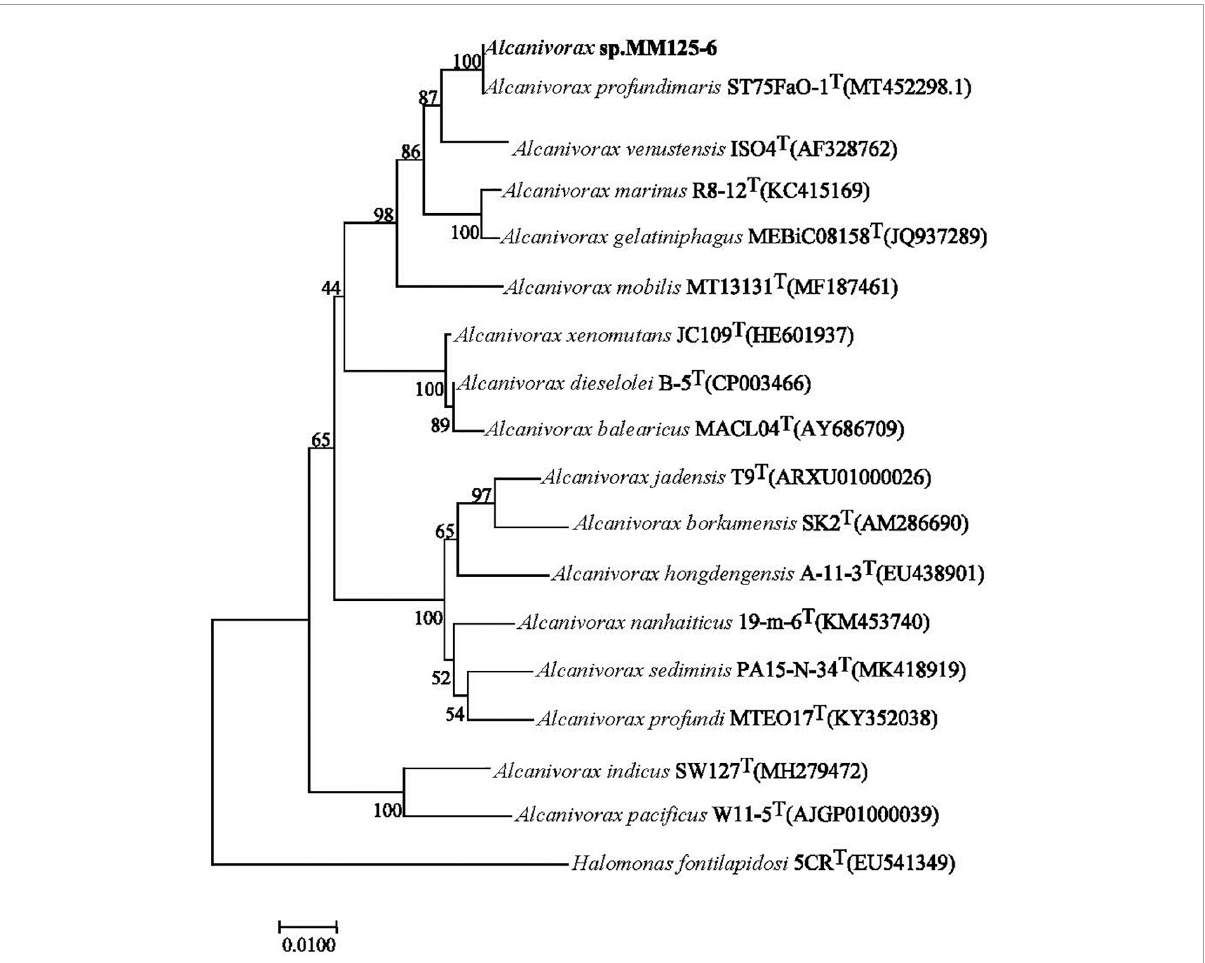
FIGURE3 Neighbor-joining tree showing the phylogenetic positions of strain MM125-6 in the genus Alcanivorax based on full-length 16S rRNA gene sequence using MEGA 7. Bootstrap value represents 1,000 replicates and random seeding. Halomonas fontilapidosi 5CR T (EU541349) was used as